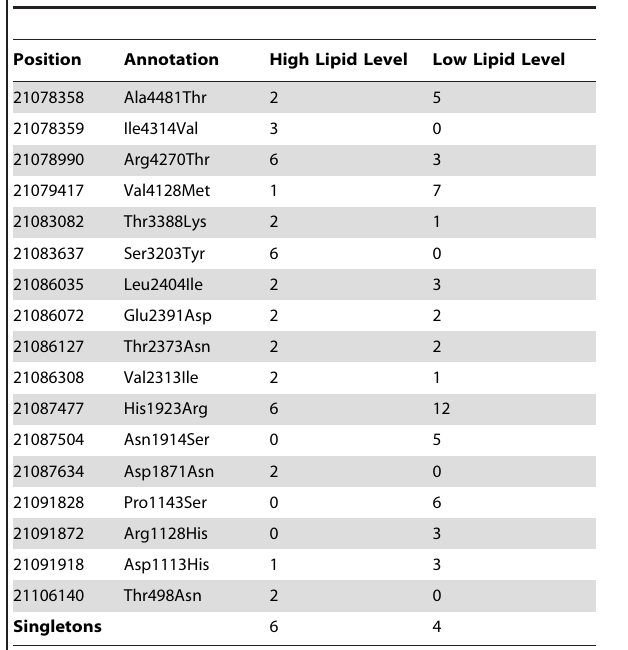
Table 1. APOB variant